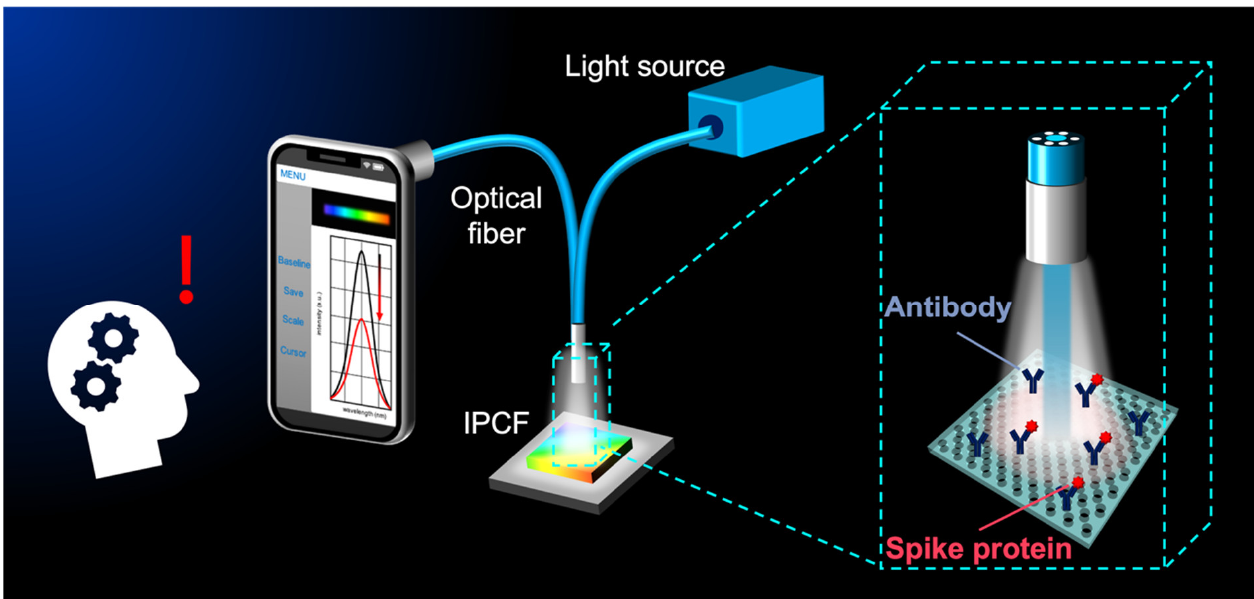
Figure 1. Conceptual illustration for smartphone-based optical detection of SARS-CoV-2 spike proteins using the imprinted photonic crystal film (IPCF) sensor.